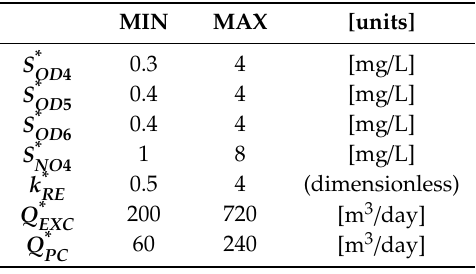
Table 3. Limits for choosing the initial population for setpoint optimization.